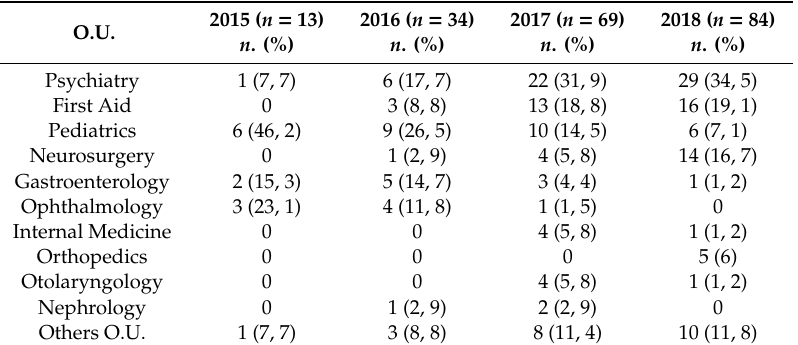
Table 1. Distribution (%) of Incident Reporting Records, by Complex Operating Unit and the reporting year.